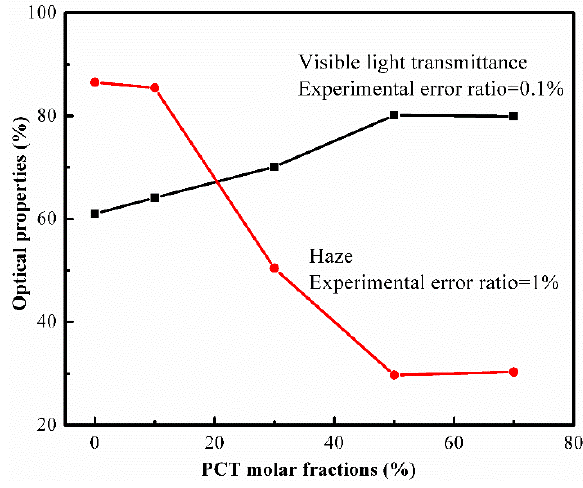
Figure 9. The optical properties of the (PBT-co-PCT)-b-PTMG copolymers.